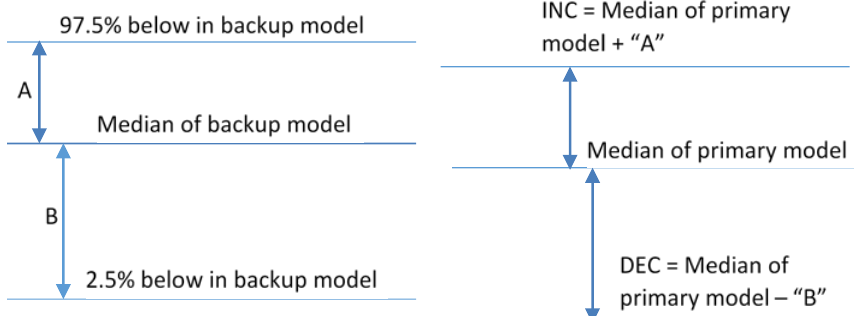
Figure 5. RA calculation of INC and DEC for a given IV state.